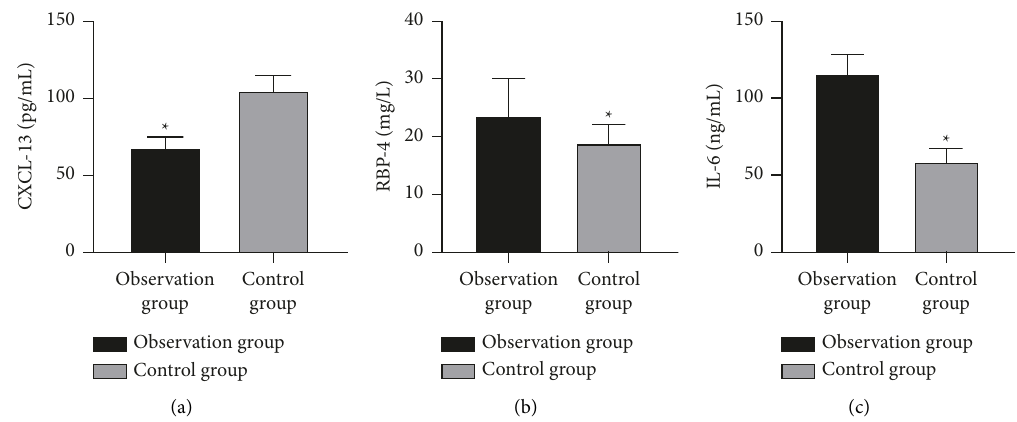
Figure 1: Comparison of serum CXCL-13, RBP-4, and IL-6 levels between the two groups. Note: compared with the control group, P 0 . 05. (a) Represents a comparison of CXCL-13 levels; (b) represents a comparison of RBP-4 levels; (c) represents a comparison of IL-6 levels. ∗ <